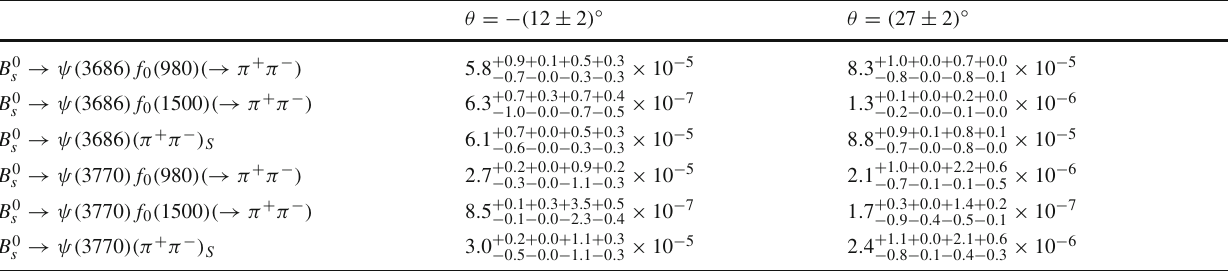
Table 2 Branching ratios of the quasi-two-decay B 0 s → ψ( 3686 , 3770 ) f 0 ( → π + π − ) in the pQCD approach based on two sets of S – D mixing angles, where the uncertainties are similar to the previous ones except the last one, which shows dependence of the mixing angle θ = − ( 12 ± 2 )